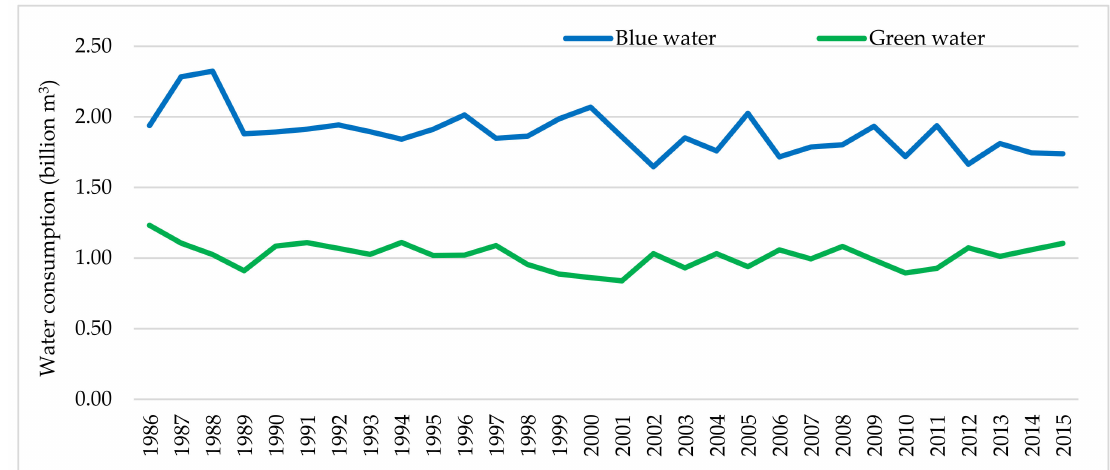
Figure 6. Variation in annual blue and green water consumption of major crops in Peshawar Basin.